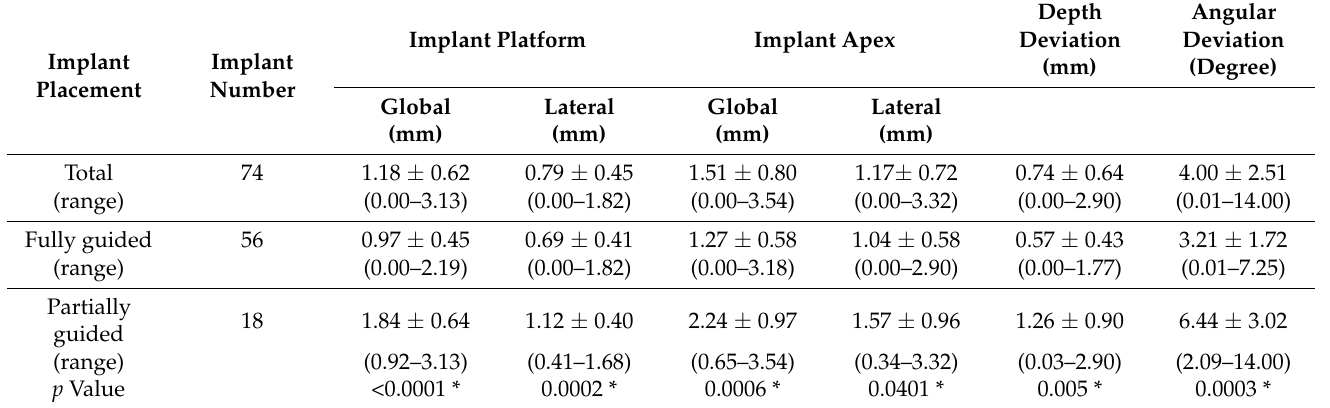
Table 2. Comparison of deviations between fully and partially guided implants.